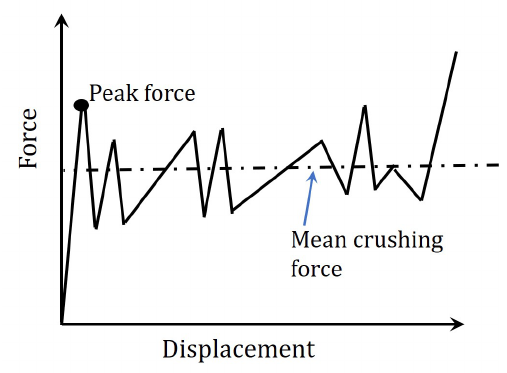
Figure 2. Schematic sketch of the load-displacement profile of composite